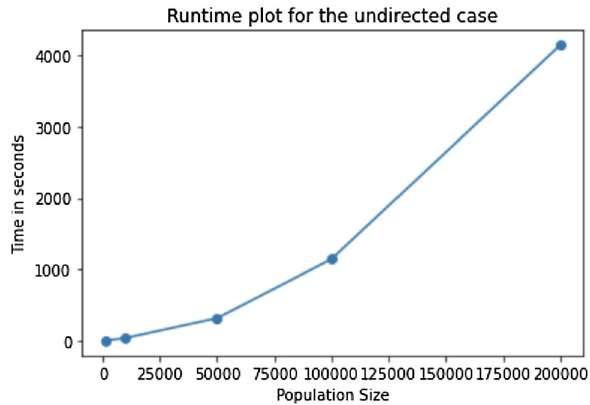
Figure 8. Comparison of the running times of the selected undirected model with different population